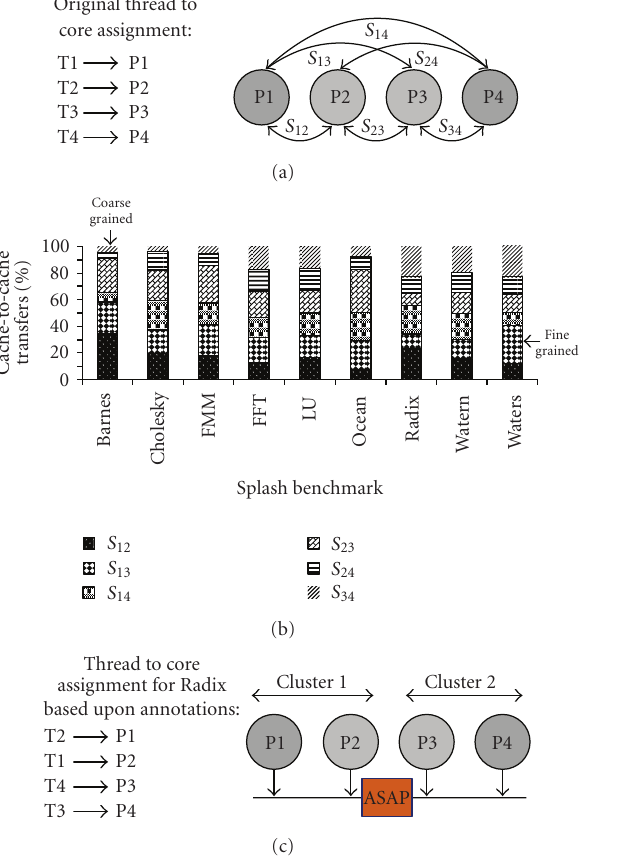
Figure 12: (a) Four cores and possible communication pairs; (b) example of annotations in splash benchmarks based upon expected communication patterns among thread pairs; (c) resulting scheduling decisions and policy selection between